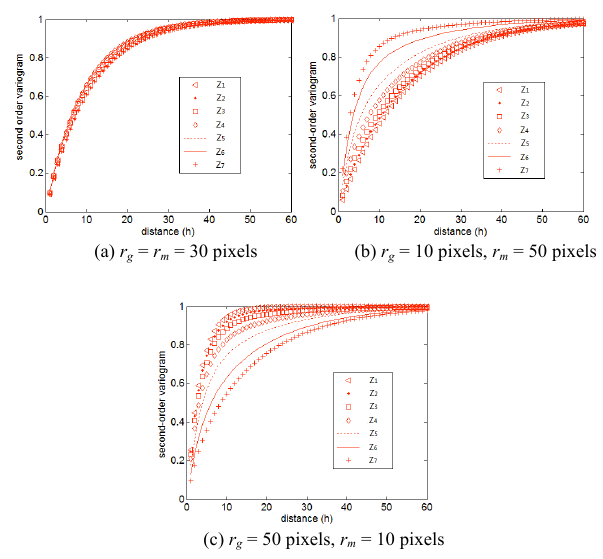
Fig.3 Experimental second-order variograms computed over images simulated from the random functions Z i ( x ), i =1,..., 7.